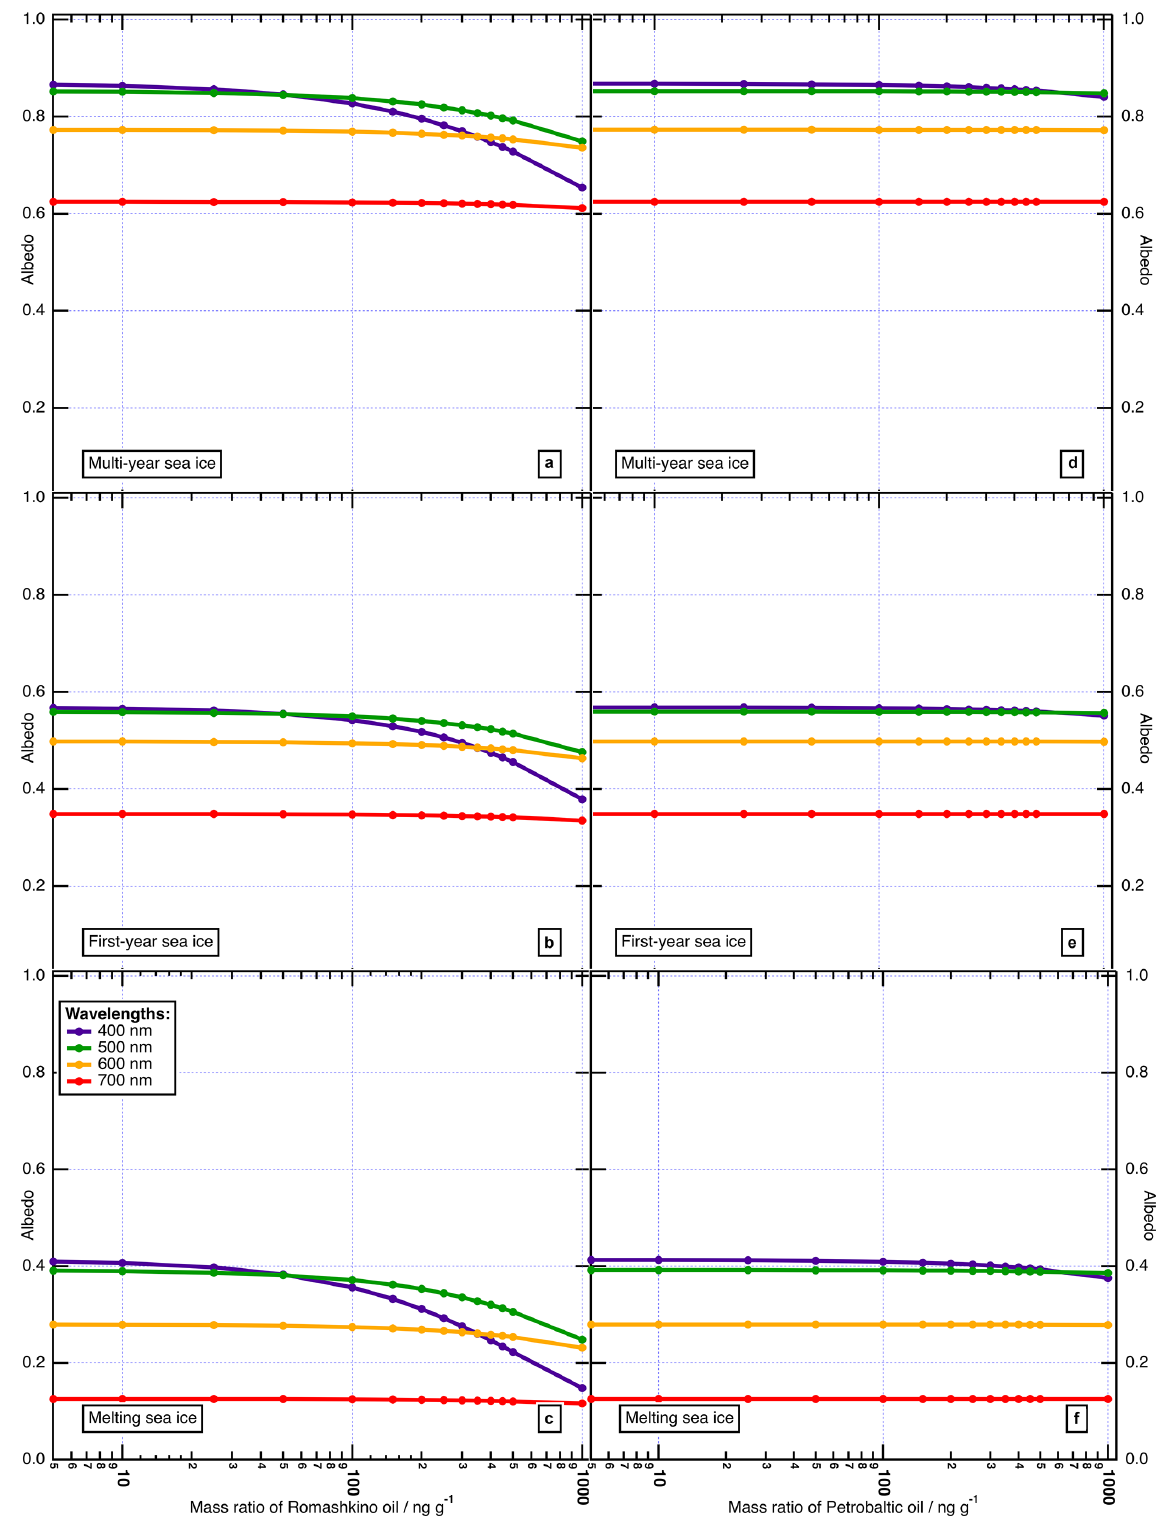
Figure 6. Albedos of multi-year, first-year, and melting sea ice with increasing mass ratios of Romashkino (a–c) and Petrobaltic (d–f) oils (0–1000ngg − 1 ) with a median droplet radius of 0.05µm. The selected wavelengths are 400, 500, 600, and 700nm. The melting sea ice and multi-year sea ice are 2.5m thick; the first-year sea ice is 0.8m thick, and their properties are described in Table 1. These data demonstrate that the type of oil rather than the type of sea ice may have the largest effect on the albedo of realistic-thickness sea ice. https://doi.org/10.5194/tc-16-3949-2022 The Cryosphere, 16, 3949–3970,